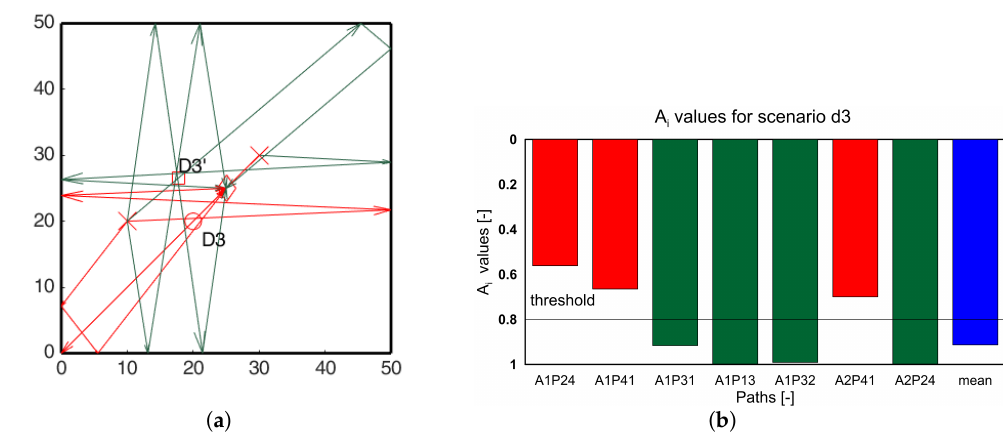
Figure 14. ( a ) Edge reflection paths passing through the identified hotspots; ( b ) A i ratio edge reflection paths passing through the identified hotspots for scenario